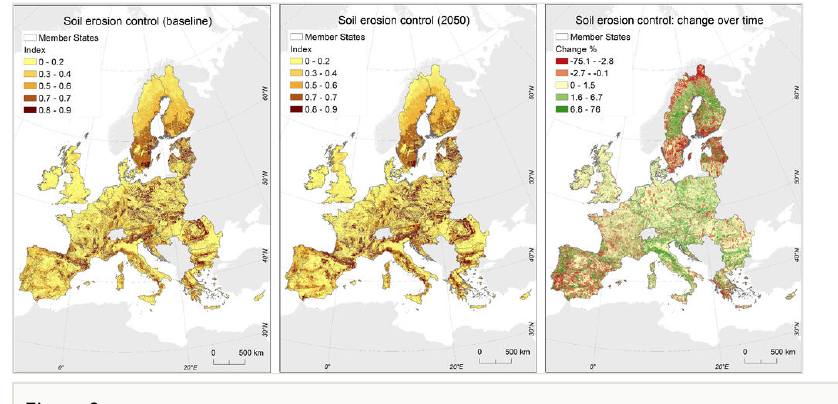
Figure 8. Soil erosion control for the baseline, the 2050 and as a percent change over time (2050 vs. baseline). For the baseline and the 2050 maps, classes represent equal intervals over the range of rendered predictions; for the percent change over time, the visual representation re fl ects the distribution of the values. Maps are displayed using the Projected Reference System LAEA. See main text for additional